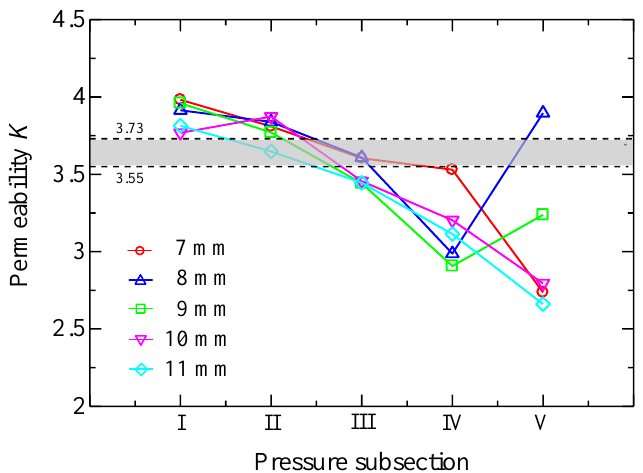
Figure 10. Pressure in the chamber versus mass flow rate obtained by the discharge method for the five porous media of group 2.